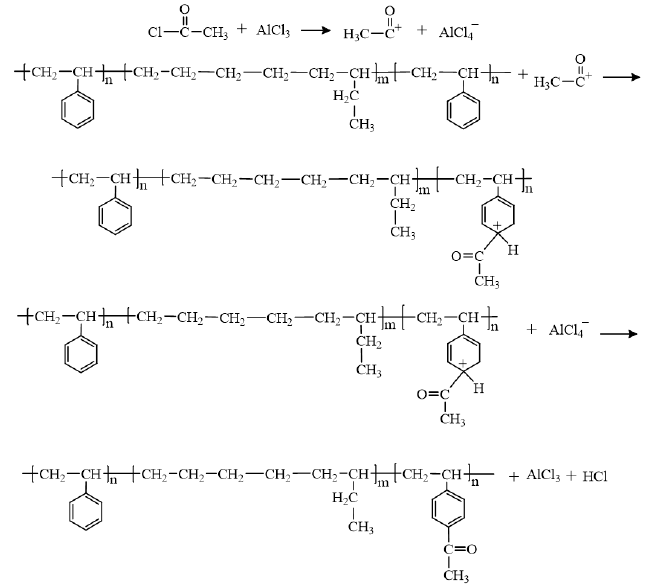
Figure 1. The preparation process of Ac-SEBS. Ac-SEBS, PP, and antioxidants were added to the torques rheometer for melting blending, in which the temperature was set at 190 ◦ C, the rotor speed was set at 60 rpm, and the mixing was 5 min, in which the content of Ac-SEBS was 30%, and the content of antioxidants was 1%. After evenly mixed samples were taken out, according to